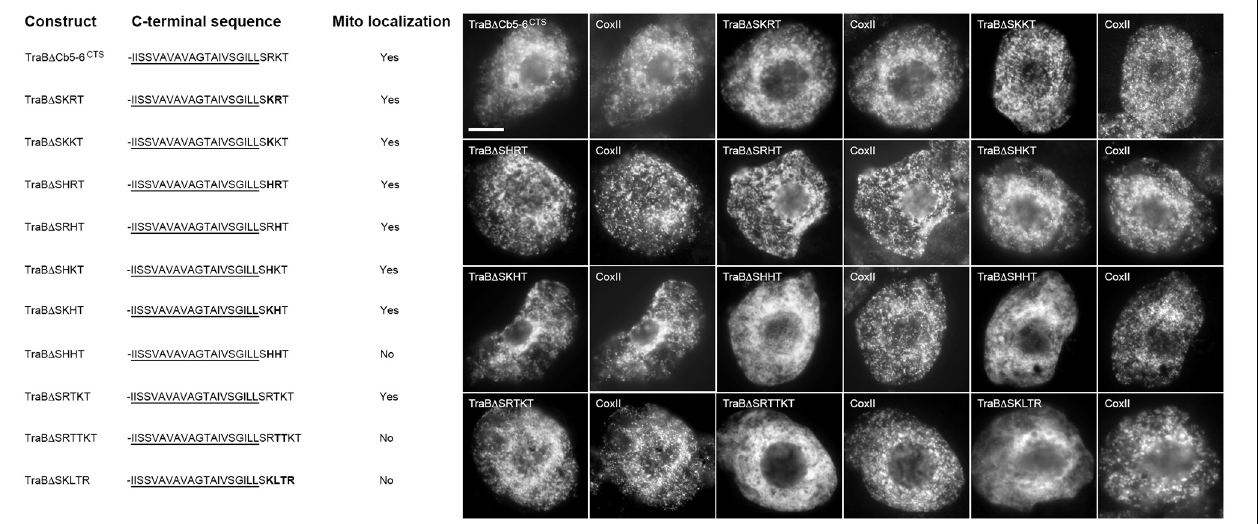
FIGURE 6 | Localization of various CTS mutant versions of the mitochondrial-TA hybrid protein TraB (cid:2) Cb5-6 CTS in BY-2 cells. Shown on the left are schematic illustrations of wild-type and various CTS mutant versions of the hybrid protein TraB (cid:2) Cb5-6 CTS and their corresponding localization (or lack thereof) to mitochondria in transformed BY-2 cells. The names of the mutant constructs represent the specific amino acids in their CTSs. All constructs possess an N-terminal-appended Myc-epitope tag. Shown for each construct is the corresponding C-terminal amino acid sequence, including putative TraB TMD (underlined) and modified (or